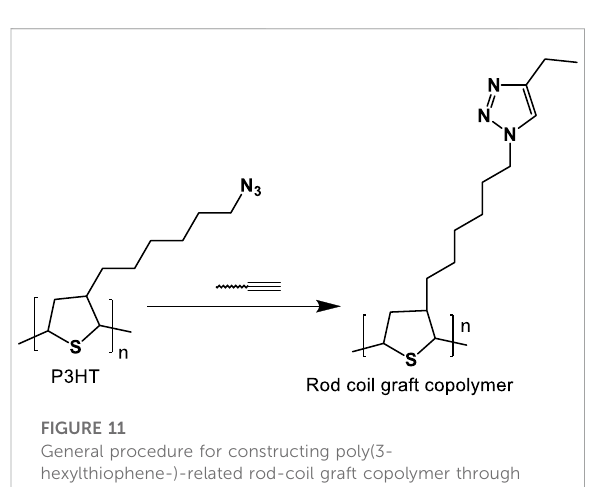
FIGURE 11 General procedure for constructing poly(3- hexylthiophene-)-related rod-coil graft copolymer through